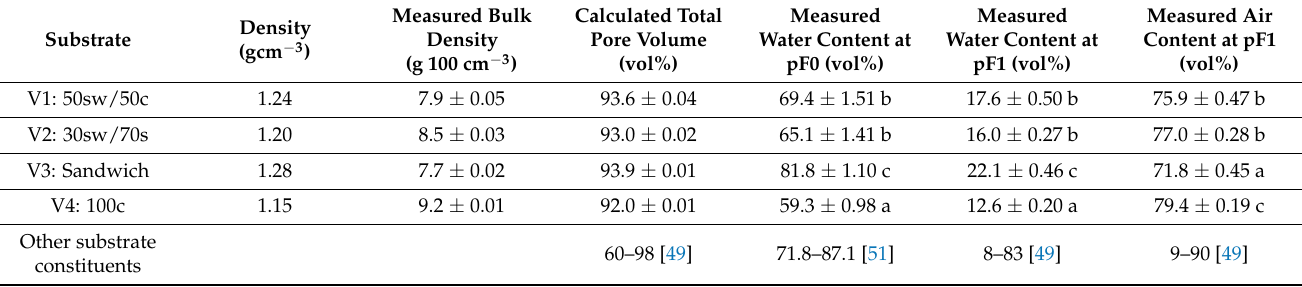
Figure 2. Influence of vegetation mats on the relationship between matrix potential and water content; V = variant of matte. Table 4. Physical properties of substrates.